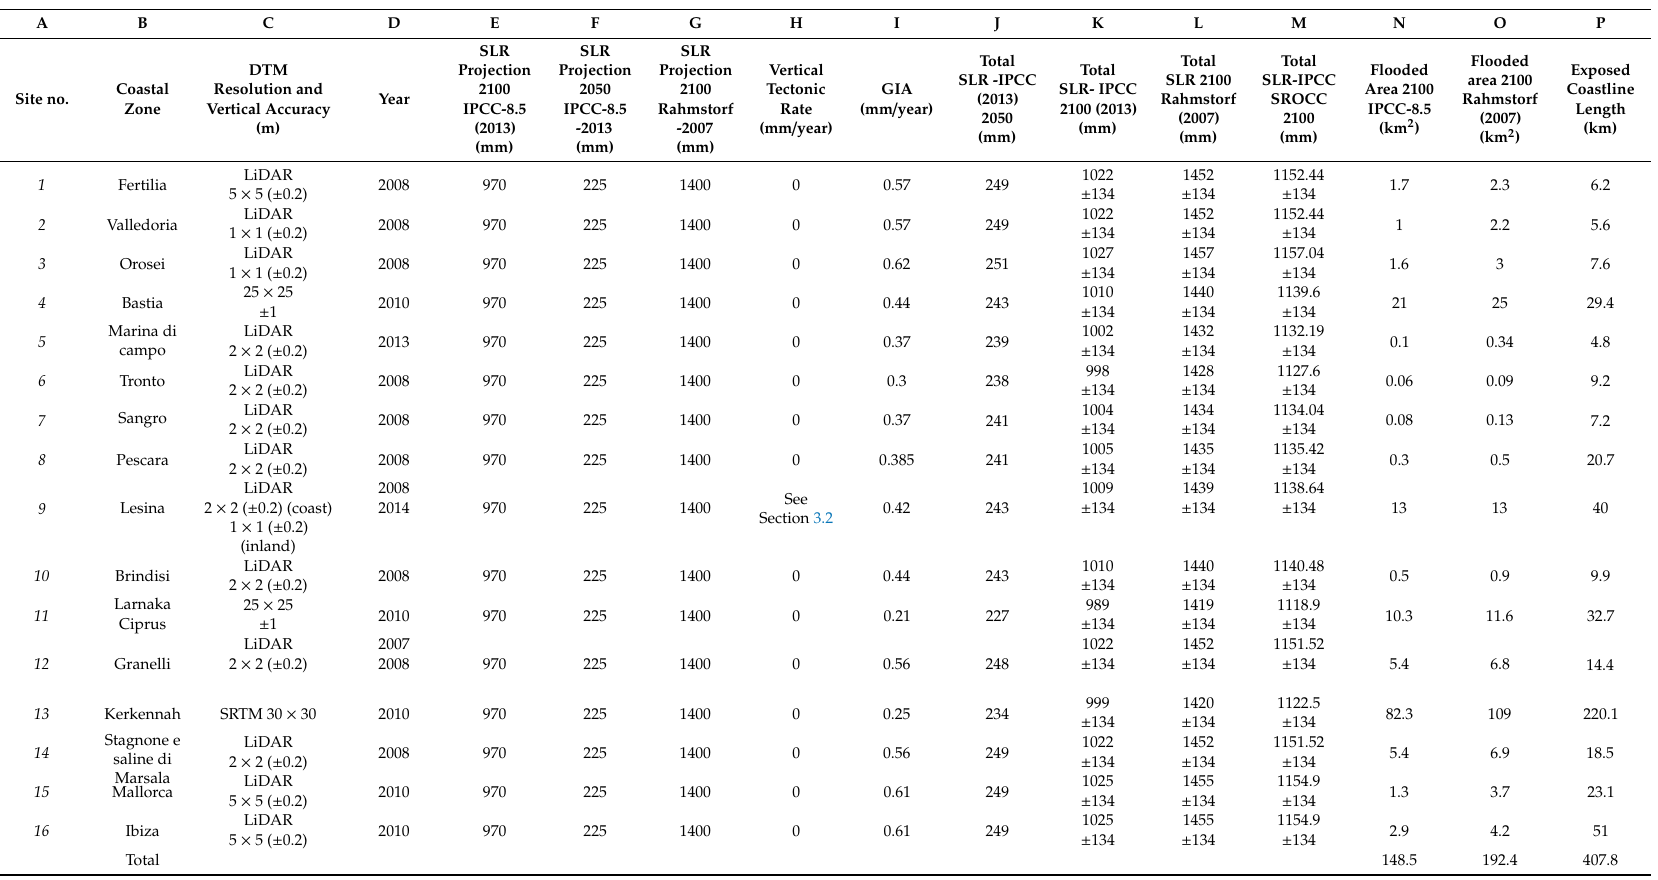
Table 3. A: site number; B: coastal zone; C: (digital terrain model, DTM) resolution and accuracy; D: epoch of DTM; E: IPCC projection AR5-RCP8.5 for 2100; F: IPCC projection AR5-RCP8.5 for 2050; G: Rahmstorf projection (2007); H: vertical tectonic rate mm / year; I: glacial isostatic adjustment (GIA) rate (Lambeck et al., 2011); J: relative sea-level rise for 2050, IPCC AR5-RCP8.5 scenario; K: relative sea-level rise for 2100, IPCC AR5-RCP8.5 scenario; L: sea-level rise for 2100, Rahmstorf